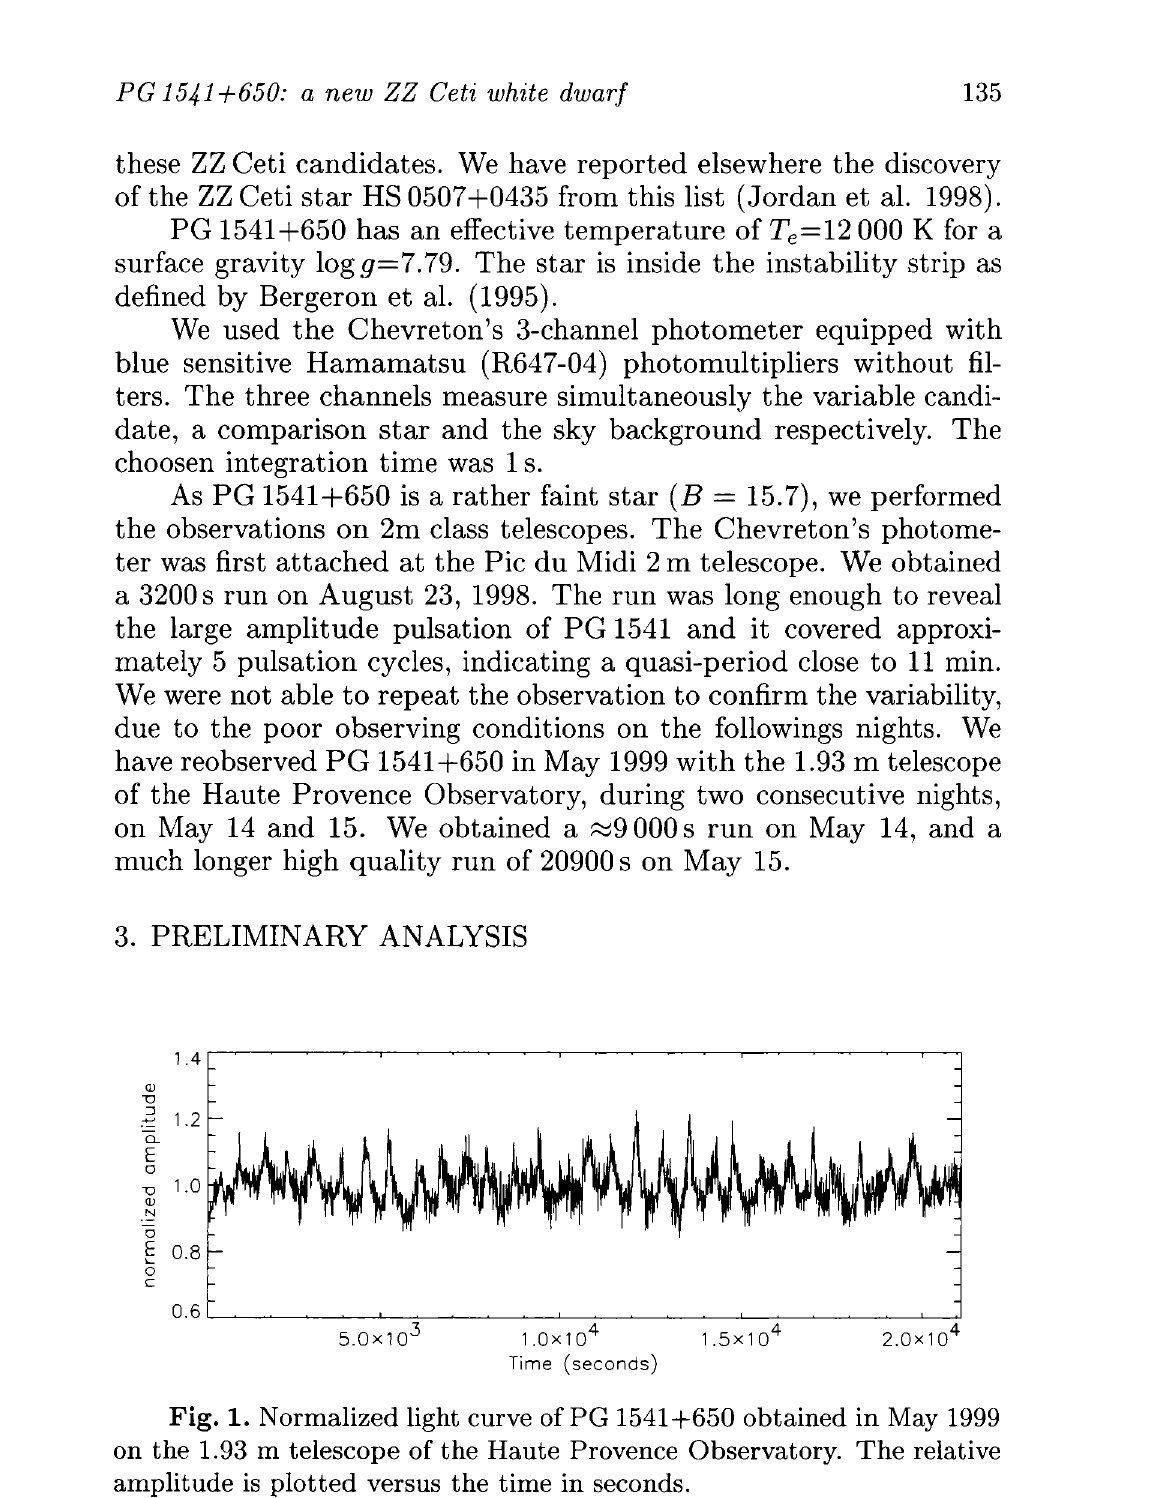
Fig. 1. Normalized light curve of PG 1541+650 obtained in May 1999 on the 1.93 m telescope of the Haute Provence Observatory. The relative amplitude is plotted versus the time in